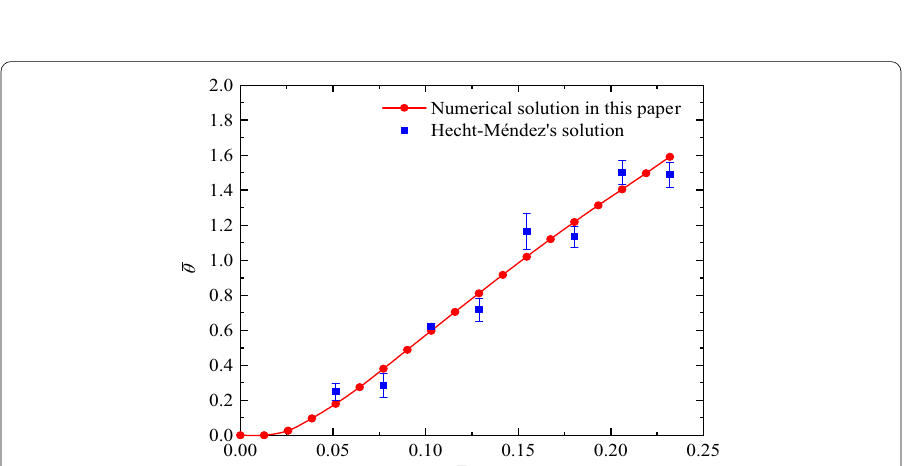
Fig. 7 Comparison of multi-tube (four tubes) numerical solution with Hecht-Méndez’s solution (Hecht-Méndez 2013): dimensionless mean temperature ( ¯ θ